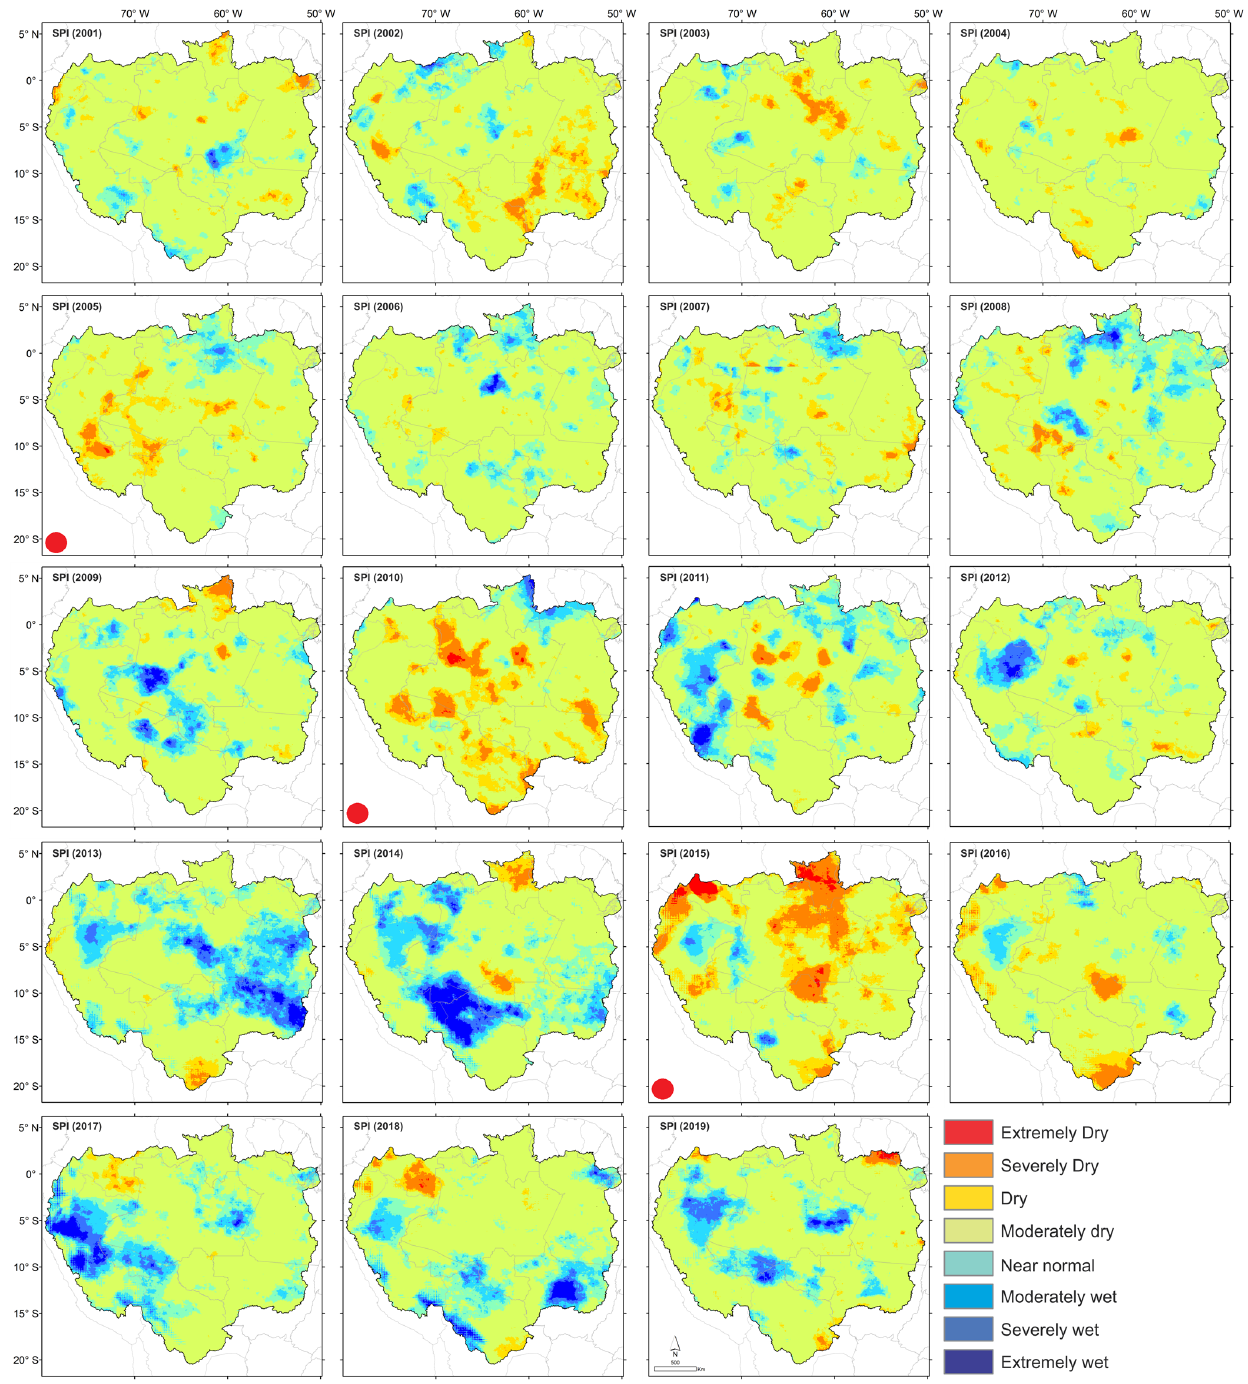
Figure 3. Measurement of each pixel in the Amazon Basin related to the standardized precipitation index (SPI) and the annual sum of the values between 2001 and 2019. Red dots indicate the occurrence of El Niño or Atlantic SST anomalies (see Figure S2).